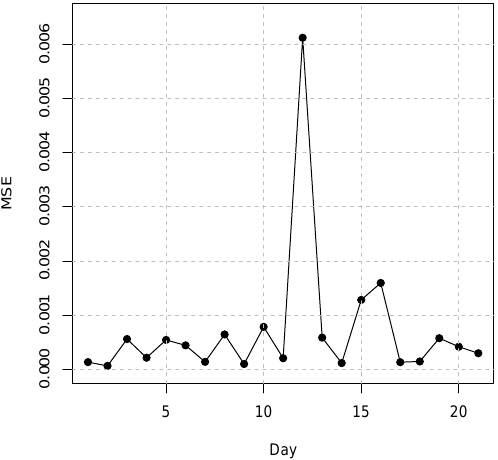
Figure 7. The MSE values for the first 21 days.